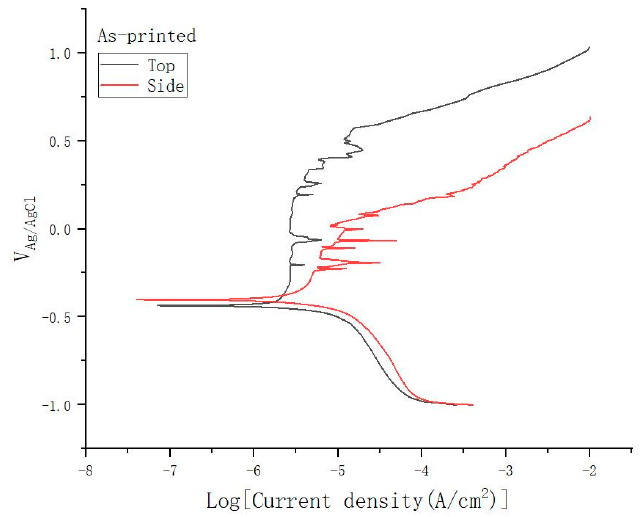
Figure 7. The polarization curve of the as-printed samples.